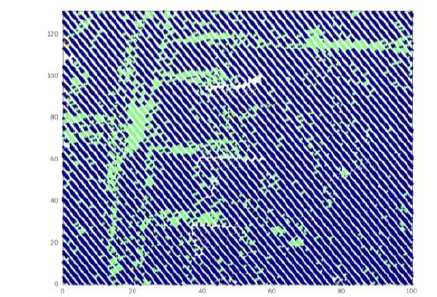
Figure 12: Number of classes assigned to each point (blue: same class for all methods, green: two different classes)